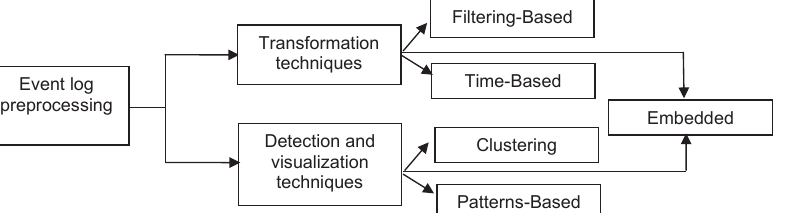
Figure 6. Proposed grouping for data preprocessing in process mining divided into two main families, transformation, and detection–visualization